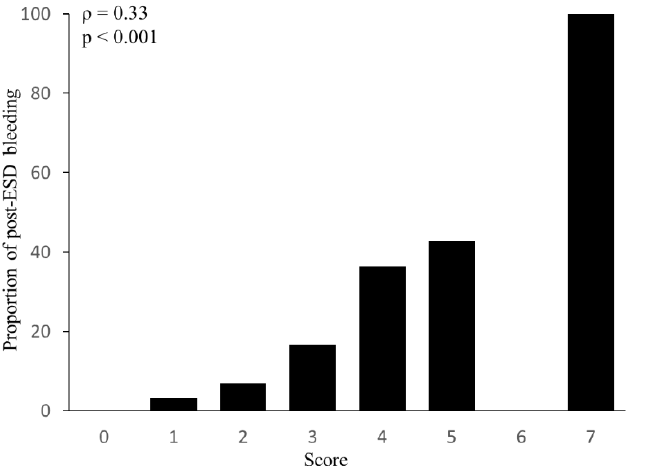
Figure 2. Modified BEST-J score points and percentage of post-ESD bleeding patients at each point in model cohort. Spearman’s rank correlation test was used to determine the correlation coefficient and p